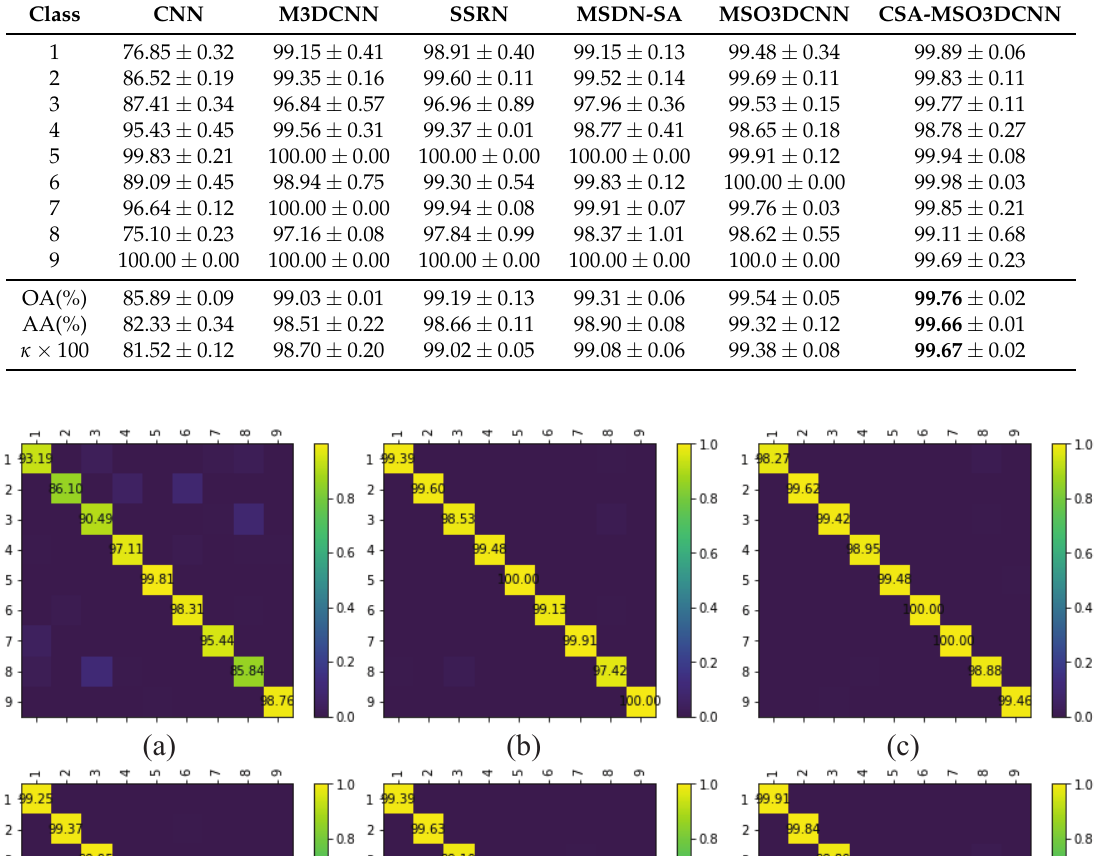
Table 6. Classification accuracy for the University of Pavia data set.